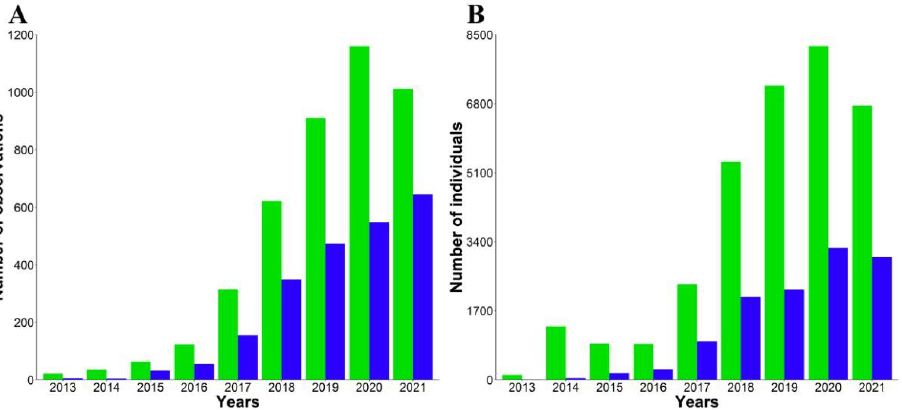
Figure 5. Number of ( A ) observations and ( B ) individuals of rose-ringed (green bars) and monk parakeets (blue bars) annually recorded on two citizen science platforms (eBird and Observation) in the study area from 2013 to 2021. Table 1. Models obtained to relate the number of rose-ringed and monk parakeet observations and individuals recorded in the citizen science platforms to our annual population counts (Survey) con- ducted in the metropolitan area of Seville from 2013 to 2021. The number of bird observations rec- orded in these platforms was fitted as an offset to control for changes in sampling effort over years. We also include models obtained to relate the number of cells with rose-ringed and monk parakeet observations recorded in these platforms to the annual population counts and the number of cells with monk parakeet nests (Nests). The number of cells with bird observations recorded in these platforms was fitted as an offset to control for changes in sampling effort over years. Dev. Expl.: deviance explained. p -values in bold font indicate statistical significance (≤0.05). See Table S5 for outputs of all the models that were run. Rose-Ringed Parakeets Dependent Variables